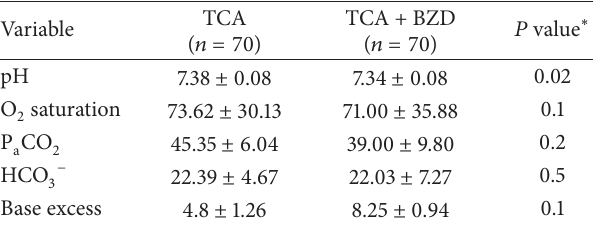
Table 3: Arterial blood gas values of the studied patients at the time of hospital